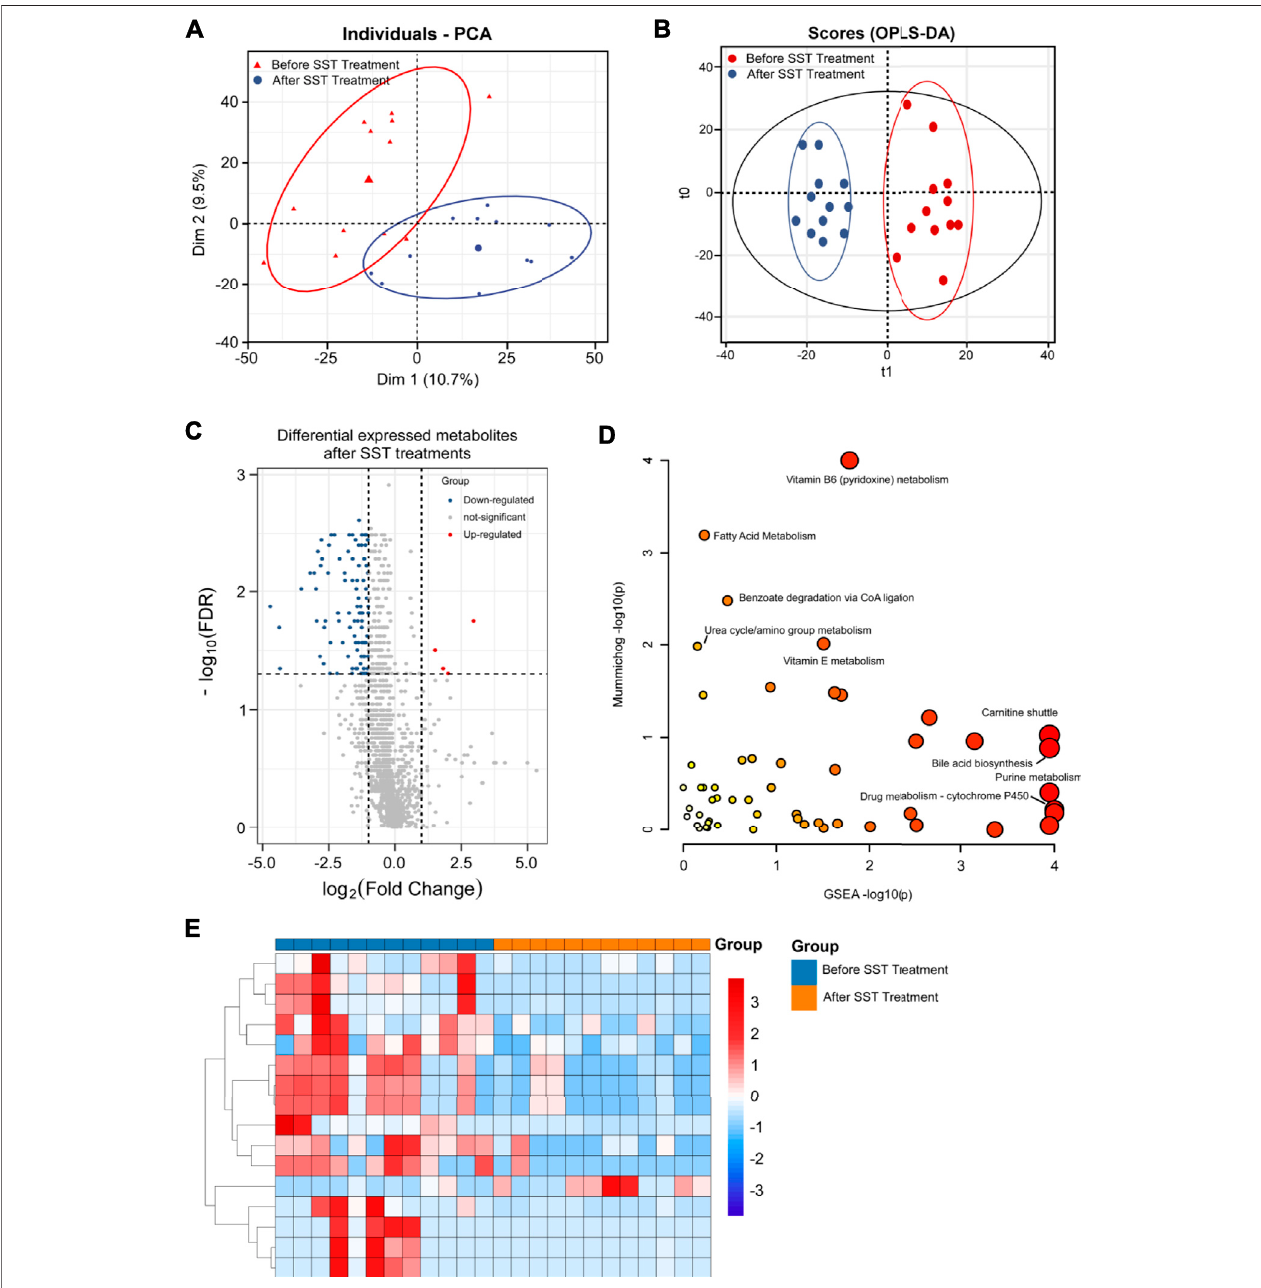
FIGURE 2 | Metabolomics analysis of breast cancer patients ’ serums after base-line chemotherapy. (A, B) PCA (A) and OPLS-DA (B) plots of the metabolites detectedinserums ofbreast cancerpatientsbeforeand afterbase-linechemotherapy(n (cid:1) 14). (C) Volcano plotshowingtheDEMs identi fi ed inserums ofbreast cancer patients after base-line chemotherapy. (D) The bubble plot showing the enriched pathways of DEMs identi fi ed in serums of breast cancer patients after base-line chemotherapy. (E) The heatmap illustrating the levels of DEMs identi fi ed in serums of breast cancer patients after base-line chemotherapy; each row represents one metabolite, and each column represents one